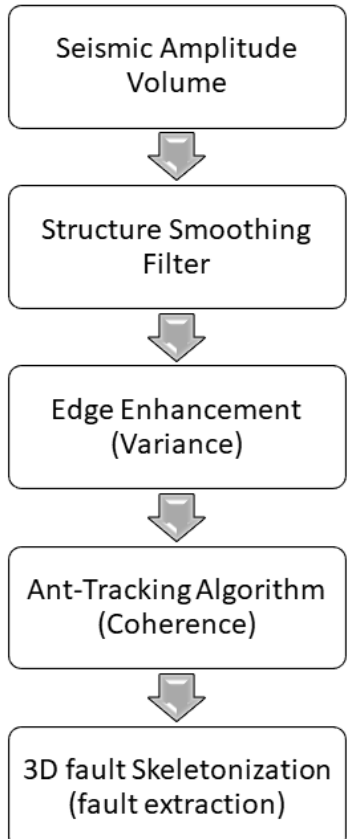
Figure 7. Workflow illustrating the steps used in our attribute analysis, which involved the generation of ant-tracking and fault extraction volumes.